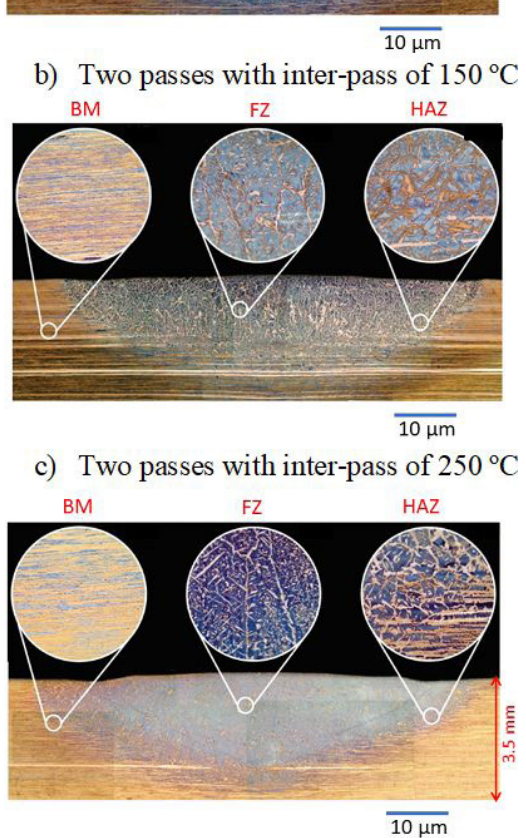
Figure 2. Microstructures of the stainless-steel tubes wall after TIG welding (Caption: BM – base metal; FZ – fusion zone; HAZ-heat affected